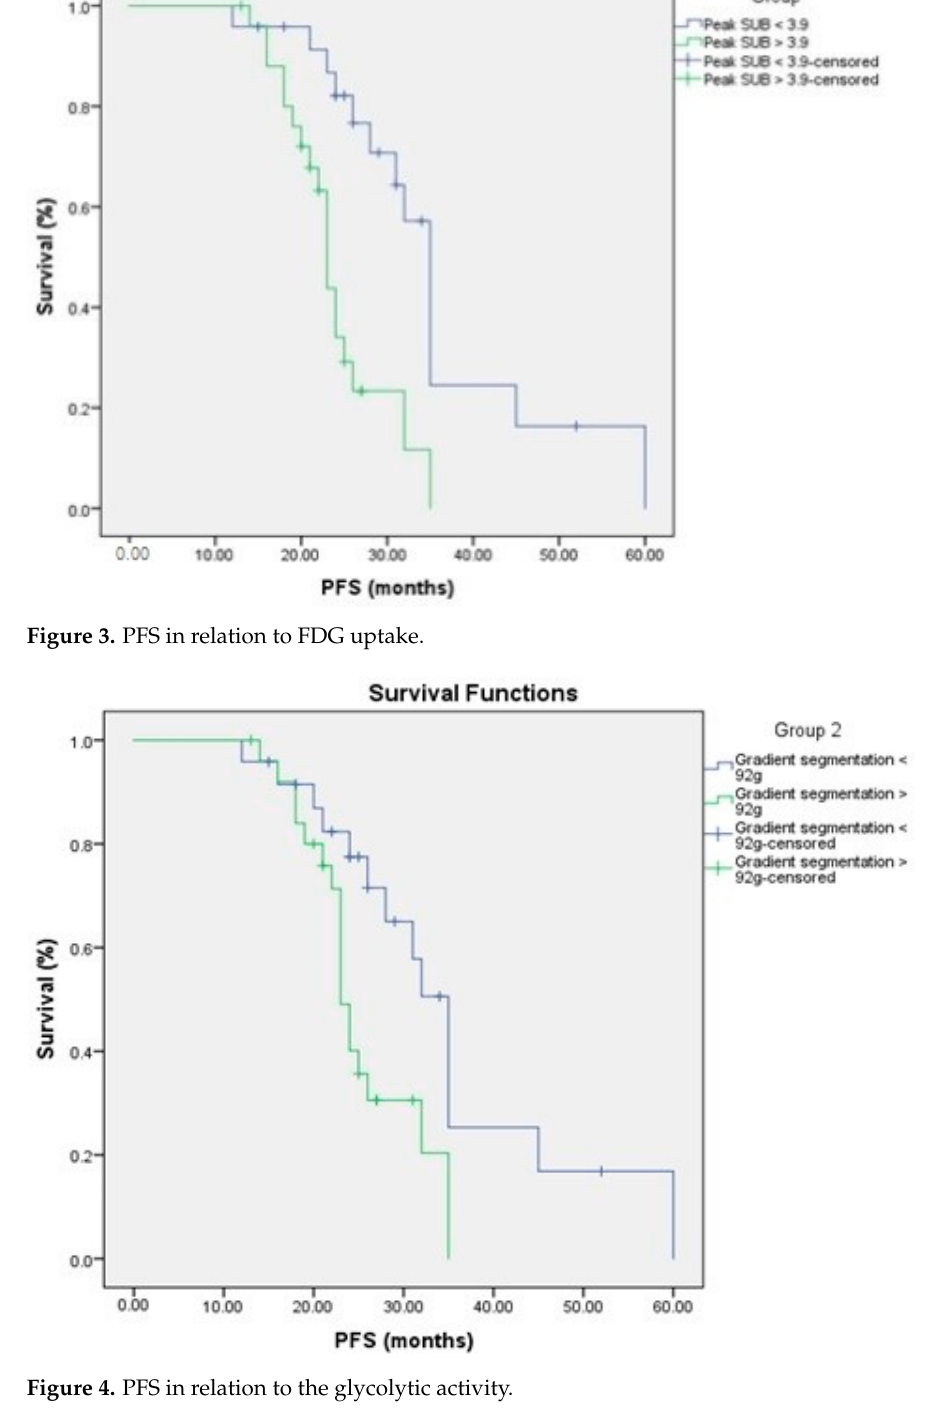
Figure 4. PFS in relation to the glycolytic activity. Table 4. Survival time means and medians